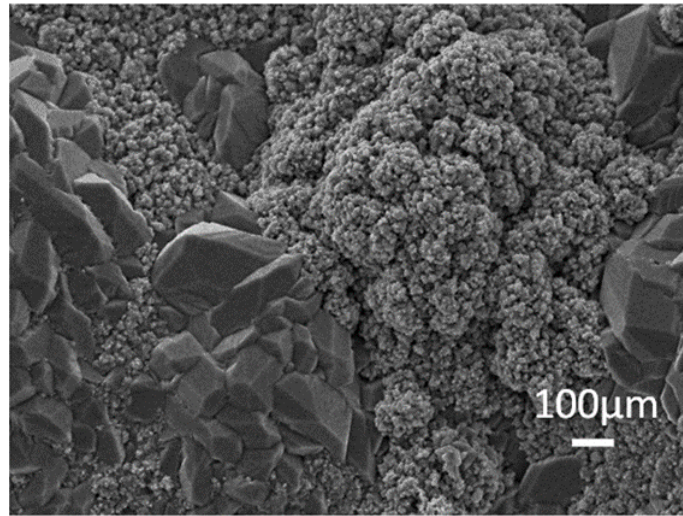
Figure 6. Results samples studied at 0 h (“A”), 8 h (“B”), and 20 h (“C”) of milling.